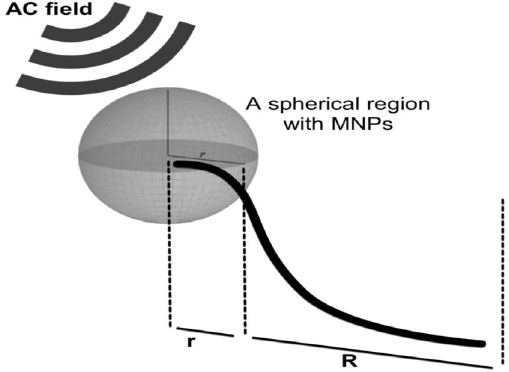
Fig 5 . Temperature vs. Distance